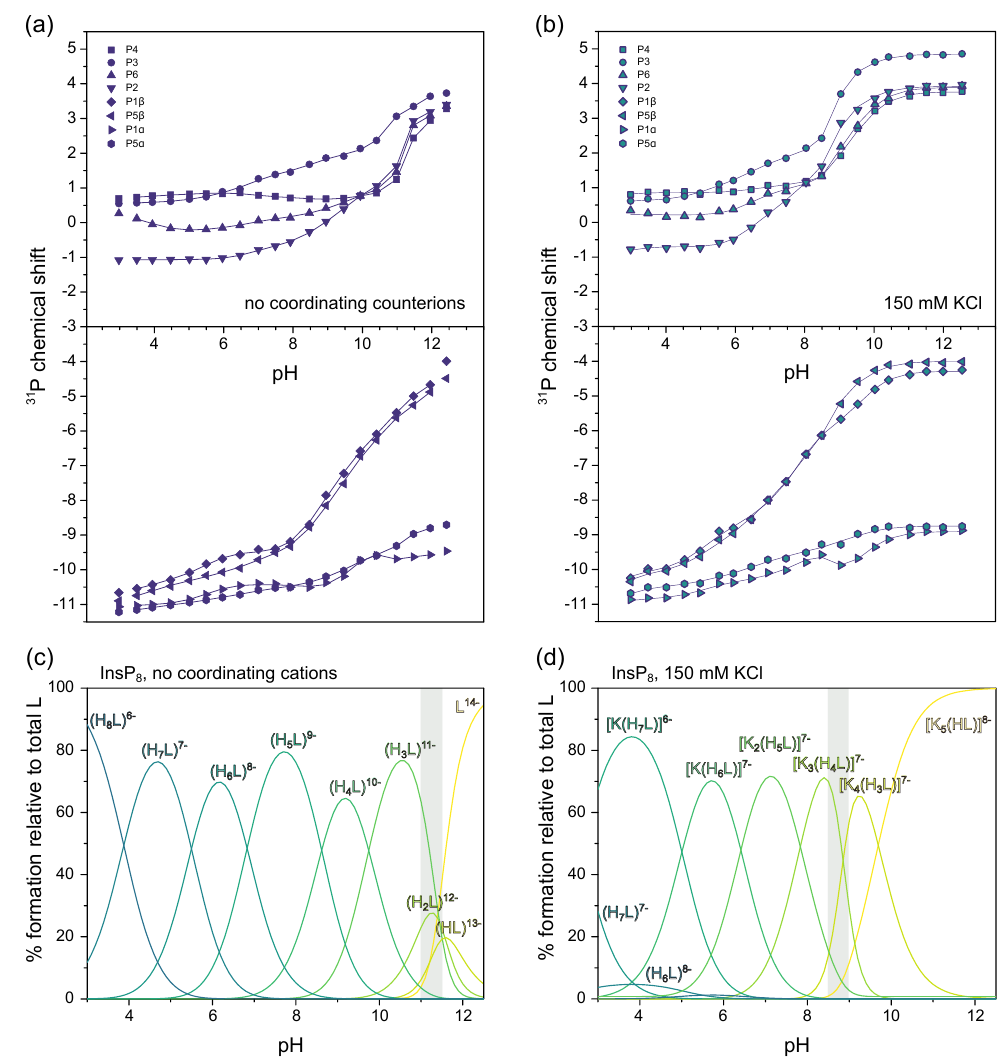
Figure 5. 31 P-NMR titrations of InsP 8 . ( a ) Chemical shift without coordinating counterions (150 mM NMe 4 Cl) at 22 ◦ C, pH 3.0–12.5. ( b ) Chemical shift with 150 mM KCl. Dots represent experimental chemical shift data, separated into monophosphate (position 2, 3, 4, 6) and pyrophosphate groups (position 1 and 5). Lines represent theoretical chemical shift values based on the protonation model and calculated protonation constants. ( c , d ) Abundance of different protonation states (no coordinating counterions) or K + -complexes (in the presence of 150 mM KCl) of InsP 8 (L) over the pH range. The grey area represents the pH-range with the biggest chemical shift changes in ( a , b